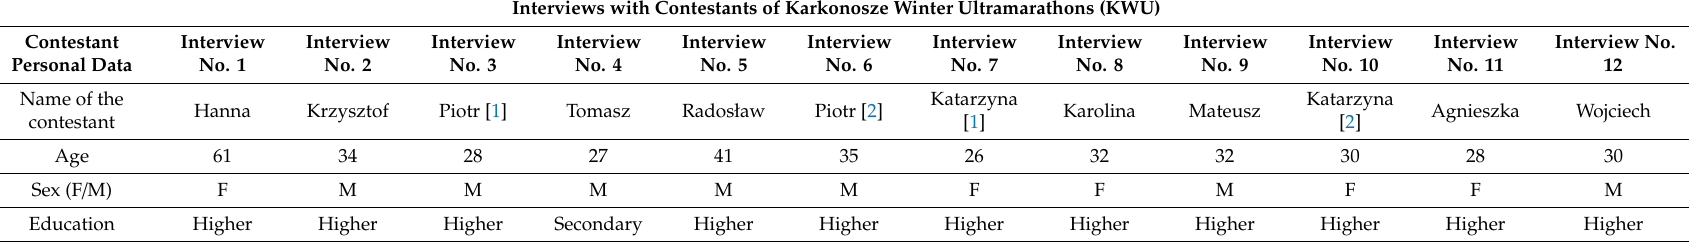
Table 1. Personal data of ultramarathon